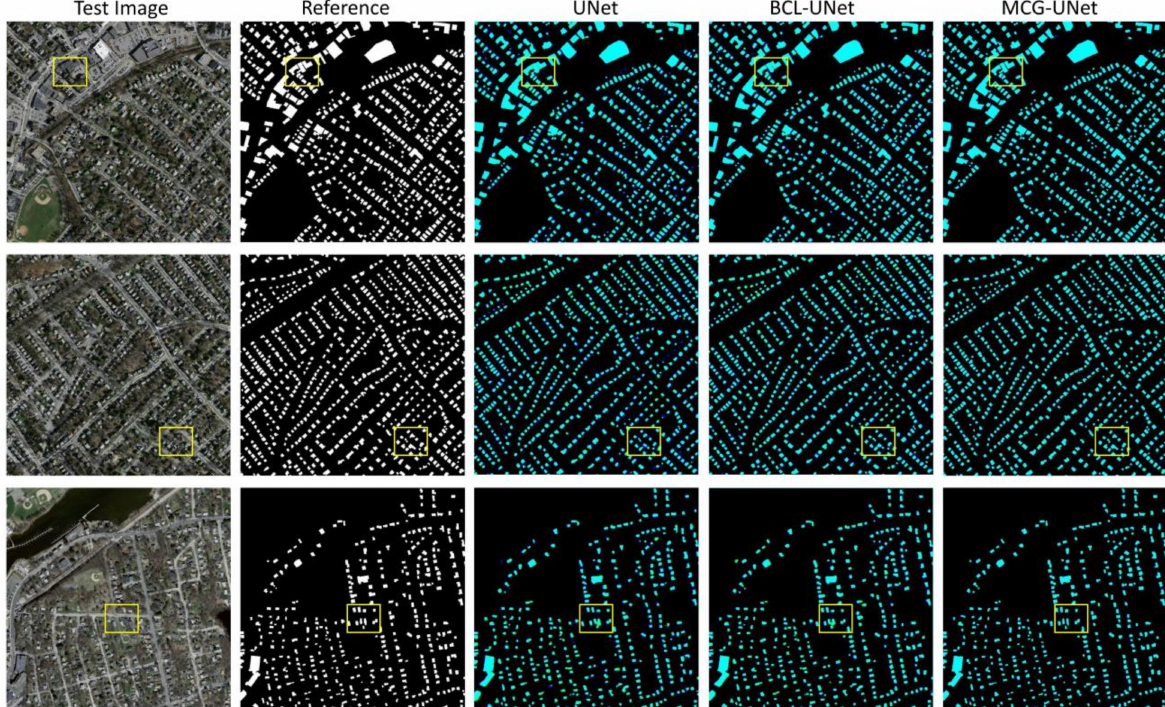
Figure 9. Obtained products with the presented UNet, BCL-UNet, and MCG-UNet networks from the Massachusetts building dataset. The blue, white, and yellow colors display the FNs, TPs, and FPs,